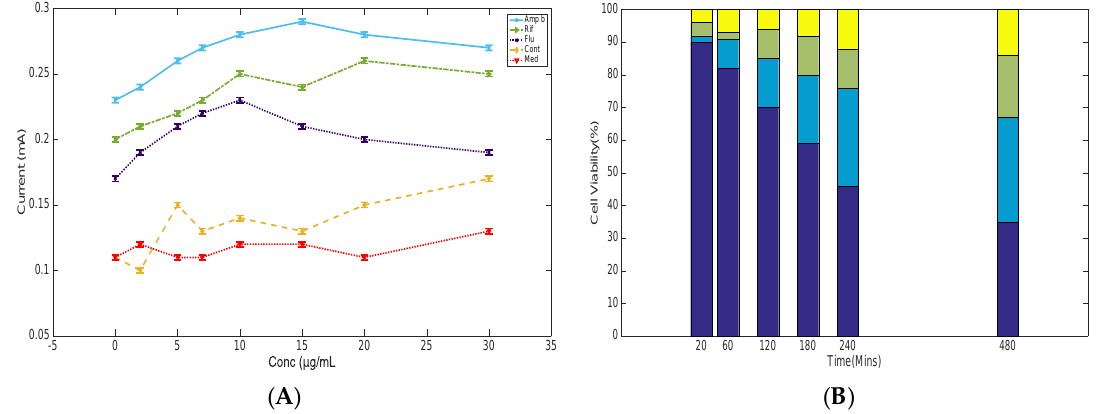
Figure 6. ( A ) Concentration-dependent profile of the change in anodic current as a function of drug concentration (amp b, blue; Rif, green; Flu, purple; untreated cells, CONT, yellow; and medium, MED, red) after 8 h of drug administration. ( B ) Percent cell viability at 15 µg/mL extract concentration with data recorded from 20 min to 8 h using trypan blue as a staining dye. Reproducibility of the data was analyzed using triplicate measurements.